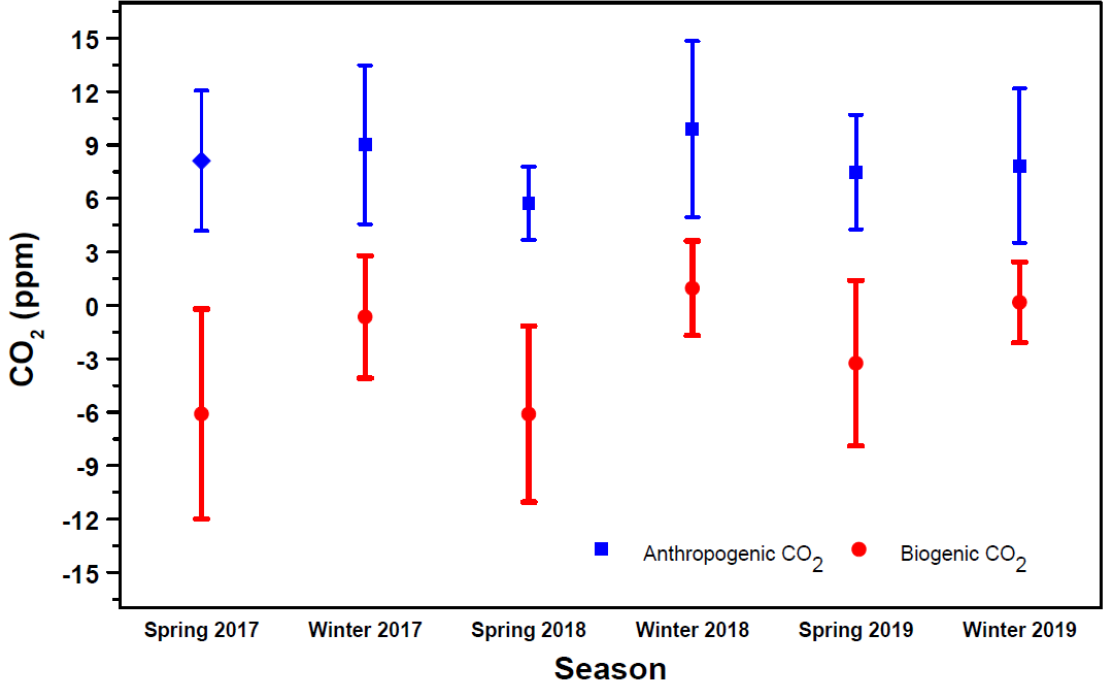
Figure 5. Seasonal wintertime and springtime biogenic (red) and anthropogenic (blue) CO 2 mixing ratios estimated using the respective wintertime and springtime β − 1 values and Equation (5).